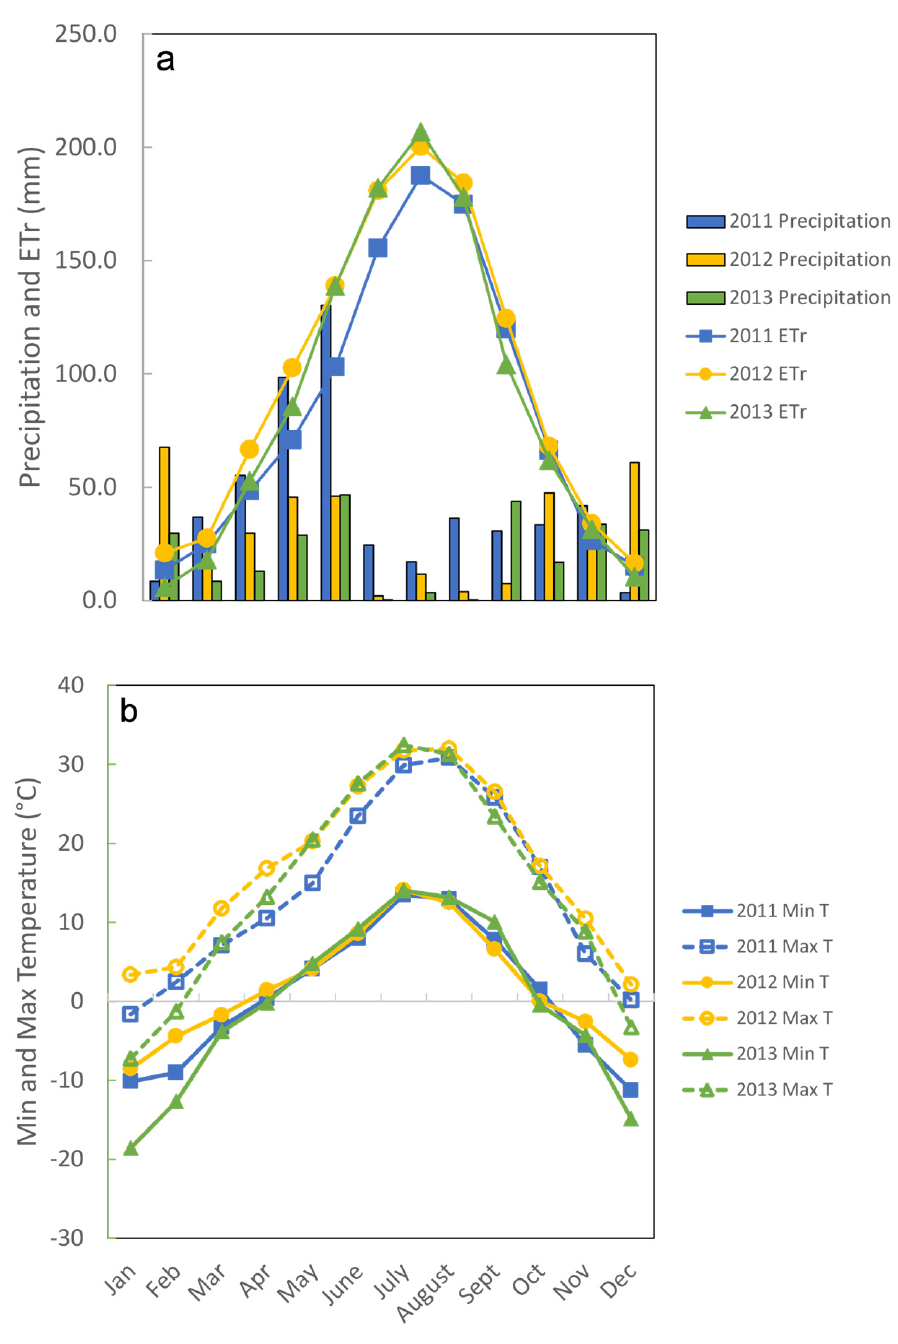
Figure 1. ( a ). Precipitation (columns) and evapotranspiration (lines) during the 3 years of the study. ( b ). Minimum (solid lines) and maximum (dashed lines) temperatures during the 3 years of the study. Comparing the forage nutritive value of the two legumes (Table 2), CMV and BFT had similar CP, aNDF and ADF, whereas CMV had greater IVTDMD, dNDF, and NDFD ( p < 0.01), than BFT, suggesting that the intake of cattle grazing CMV might exceed that of cattle grazing BFT, which was the case in 2011 and 2013 (Table 1). Comparing MBG with the legumes in 2013, the CP and NFC were less and the aNDF and ADF were greater for the grass than for the legumes. The aNDF and NFC values of the three legumes were similar to those of the concentrate diet, which contained 15% CP, 31% NDF, and 43% NFC